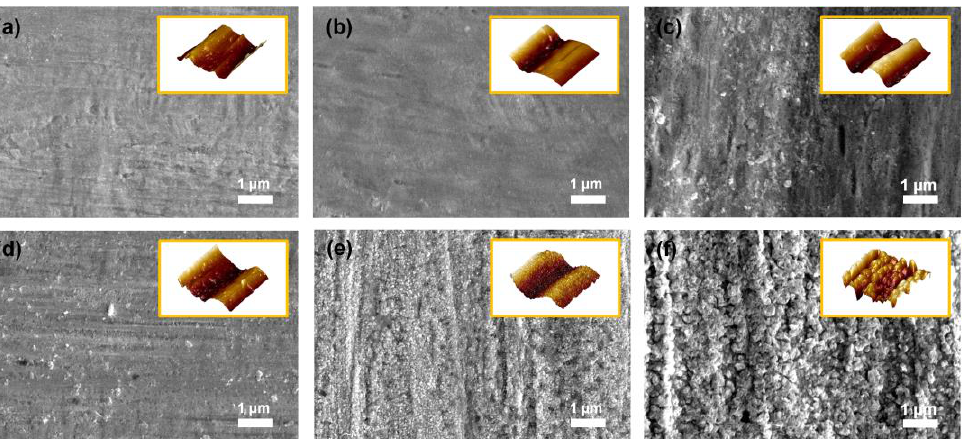
Figure 2. FE – SEM images of the top-view morphology of ( a ) PN, ( b ) Ni100, ( c ) Ni200, ( d ) Ni300, ( e ) Ni400, and ( f ) Ni500. The yellow boxed insets in each image indicate AFM 3D topography for each sample.